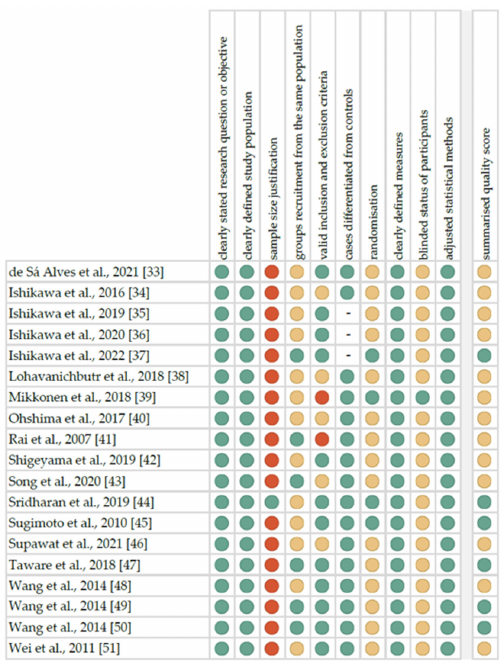
Figure 2. Quality assessment, including the main potential risk of bias (risk level: green—low, yel- low—unspecified, red—high; quality score: green—good, yellow—intermediate, red—poor).